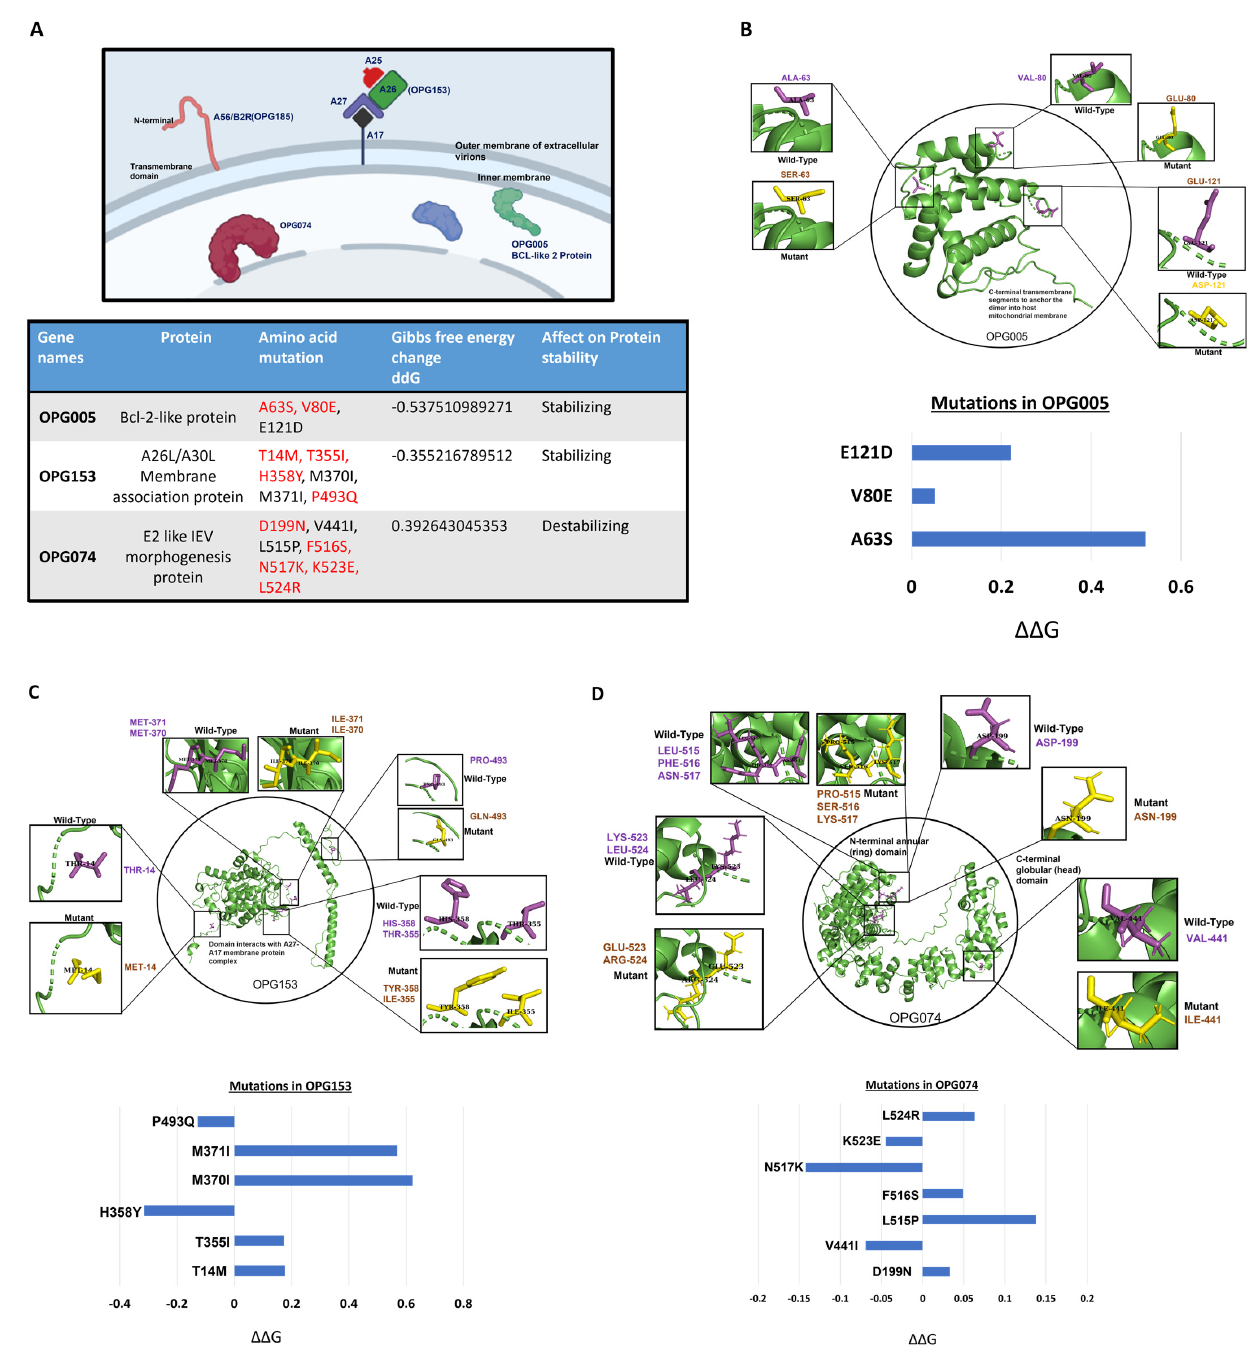
Figure 4. Structures depicting the mutations in the host cell binding viral proteins. ( A ) The localization of the OPG005, OPG153, and OPG074 viral proteins in the monkeypox virus structure. These three mentioned proteins are involved in host cell binding and were used to analyze the Gibbs free energy change due to the mutations in Indian strain: ( B ) OPG005; ( C ) OPG153; ( D ) OPG074. The Swiss Model structures show the position of the amino acid substitution mutation; pink shows the wildtype, and yellow shows the mutant-type amino acid.